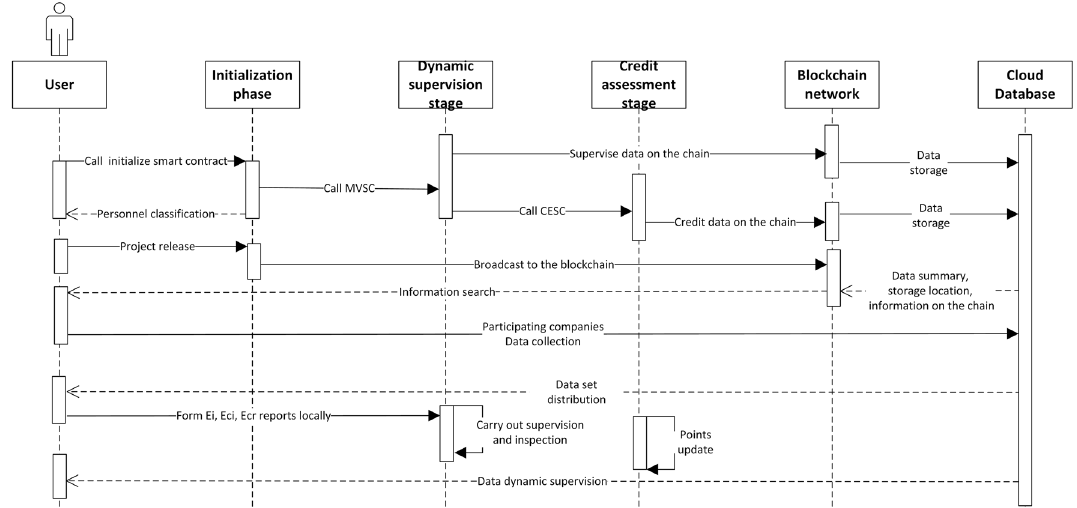
Figure 6. Operation sequence diagram of the dynamic supervision model for the rice supply